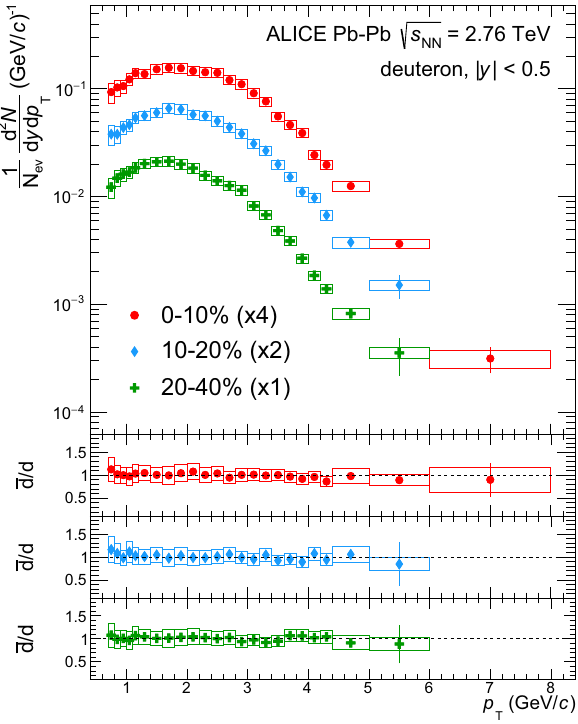
Fig. 3 In the upper panel the deuteron p T spectra are shown for the three centrality intervals extended to high p T with the TOF and HMPID analyses. In the lower panels the ratios of anti-deuterons and deuterons are shown for the 0–10%, 10–20% and 20–40% centrality intervals, from top to bottom. The ratios are consistent with unity over the whole p T range covered by the presented